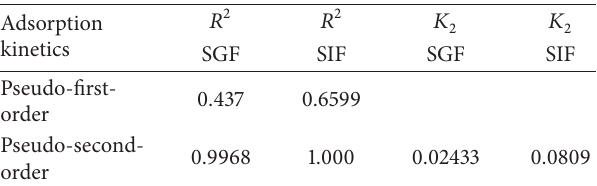
Table 6: Comparison of coefficient of determination, 𝑅 2 .